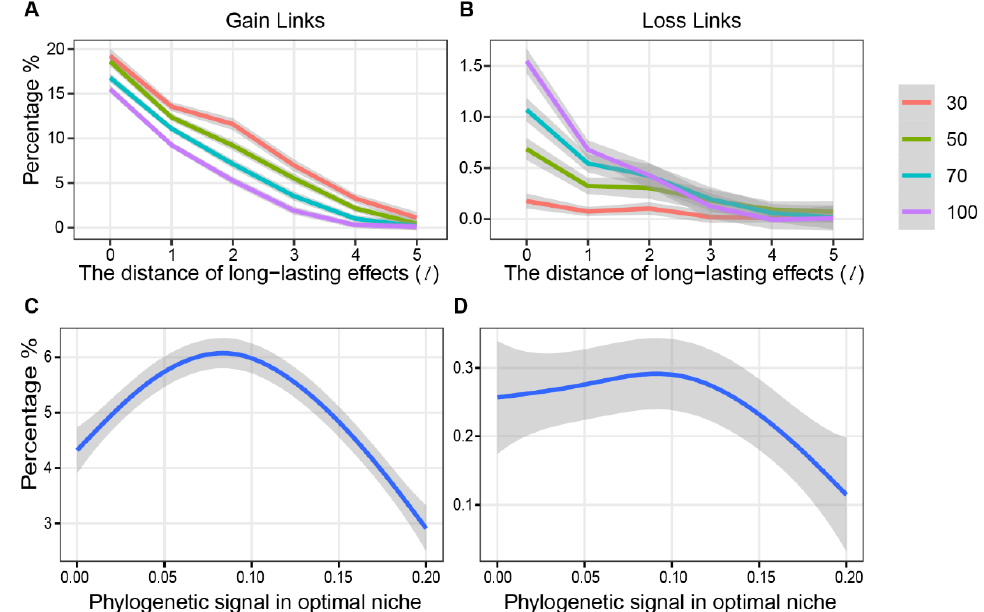
Figure 6. The response of network links in the changes in environmental heterogeneity. The gain links ( A ) and loss links ( B ) of the network across the distance of long-lasting effects ( l ) and community size ( N ; labeled with different colors) when environmental heterogeneity changes. The lines are a Loess fit based on 600 iteration points (6 × 100 replicates). The shaded regions indicate standard errors of the Loess curves. The gain links ( C ) and loss links ( D ) of the network across the phylogenetic signal in optimal niches (here, l = 2 and S = 50). The lines are fitted by generalized additive models (GAM) based on 10,000 iteration points (100 × 100 replicates). The shaded regions indicate standard errors of the curves of GAM.